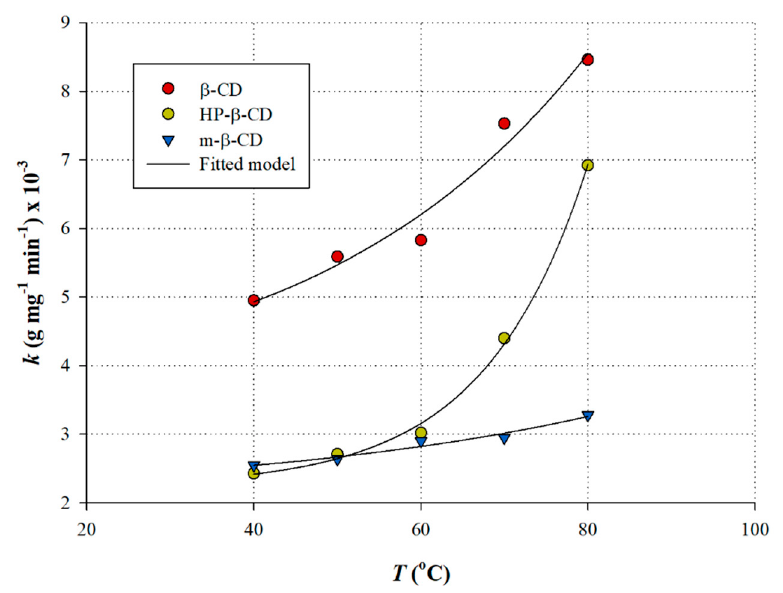
Figure 7. Non-linear regression between second-order extraction rates ( k ) and T . Table 8. Fitting parameter values determined by correlating second-order extraction rates ( k ) with T . CD CD